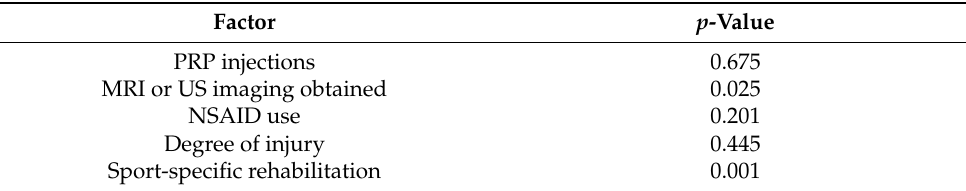
Table 2. The effect of treatment methods, injury severity, and imaging modality on injury recurrence rate (Pearson’s chi-squared test). Factor p -Value PRP injections 0.675 MRI or US imaging obtained 0.025 NSAID use 0.201 Sport-specific rehabilitation